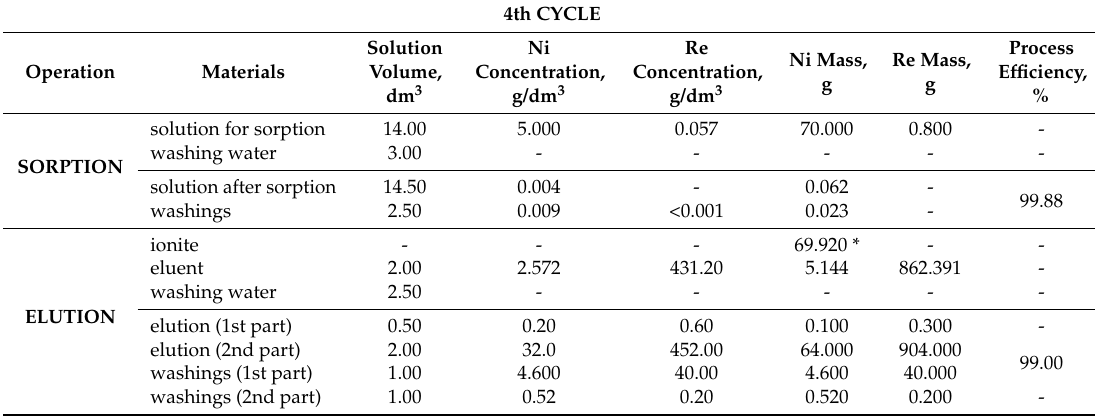
Table 18. Balance for nickel(II) sorption and elution—4th cycle.